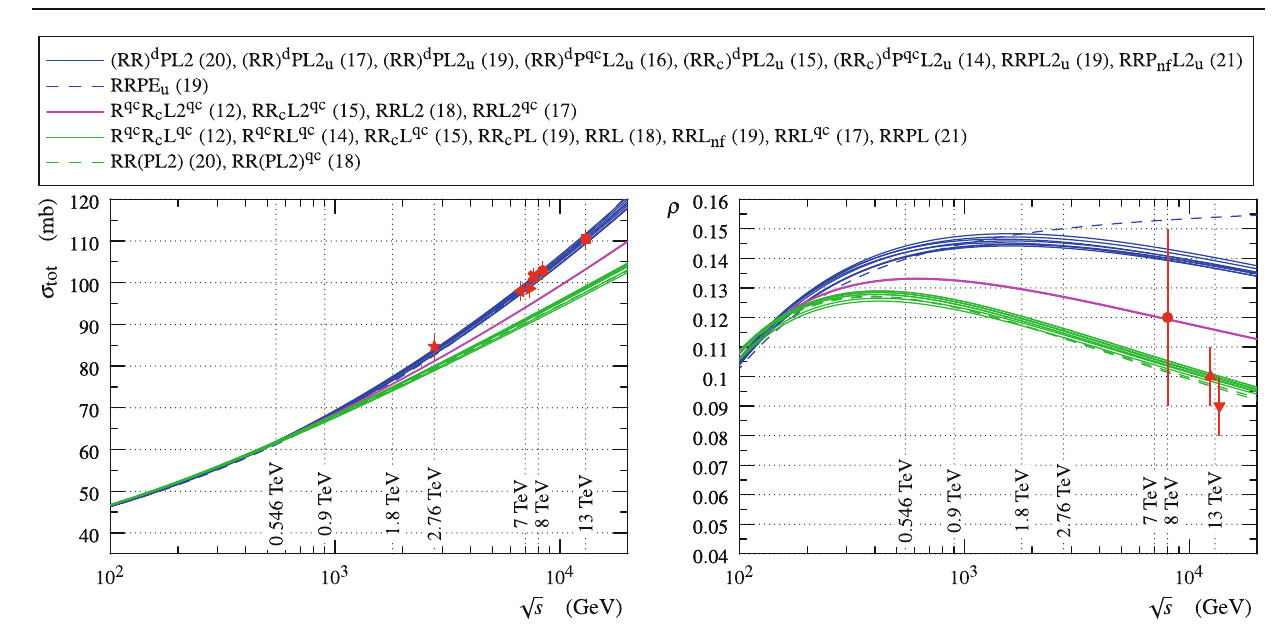
13TeV correspond to the two cases discussed in Sect. 6.2: the left point tothefitwith N b = 3and | t | max = 0 . 15GeV 2 ,therightpointto N b = 1 and | t | max = 0 . 07GeV